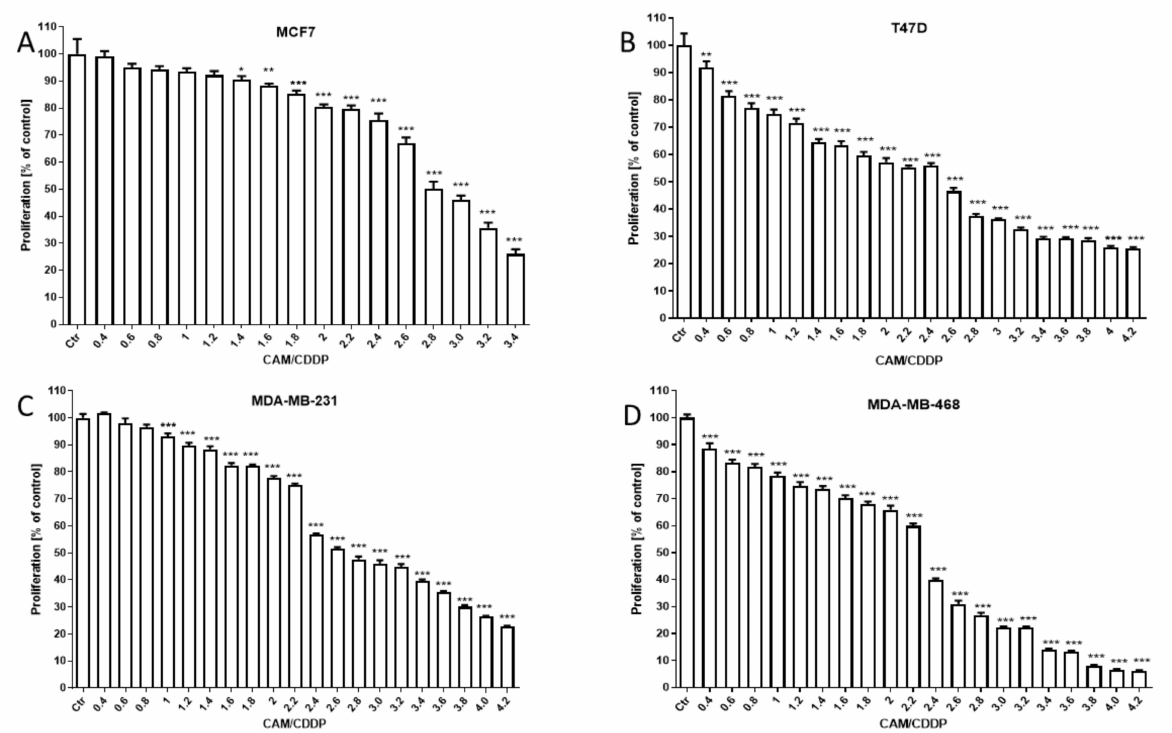
Figure 2. The antiproliferative effect of CAM and CDDP administered in combination against BC cell lines ( A – D ). Inhibition of cell proliferation was measured by the MTT assay after 96 h treatment with various concentrations of active agents. The antiproliferative effect of CAM and CDDP administered in combination with 1:1 drug mixture in increasing concentrations. All BC cell lines were exposed to CAM and CDDP mixture treatment using different ratios of IC 50 (2.0 means IC 50 of CAM + IC 50 of CDDP). All results were analyzed using GraphPad Prism 9.0 software (ordinary one-way ANOVA; Dunnett’s multiple comparisons test). Statistical differences were considered relevant at p < 0.05 (* p < 0.05, ** p < 0.01, *** p < 0.001 versus the control). Data are expressed as mean ± standard deviation of the mean ( ±